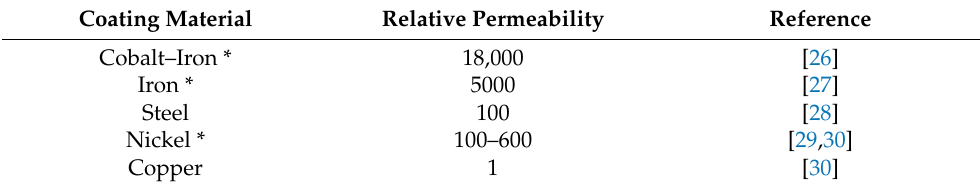
Table 2. Magnetic permeability of selected materials.